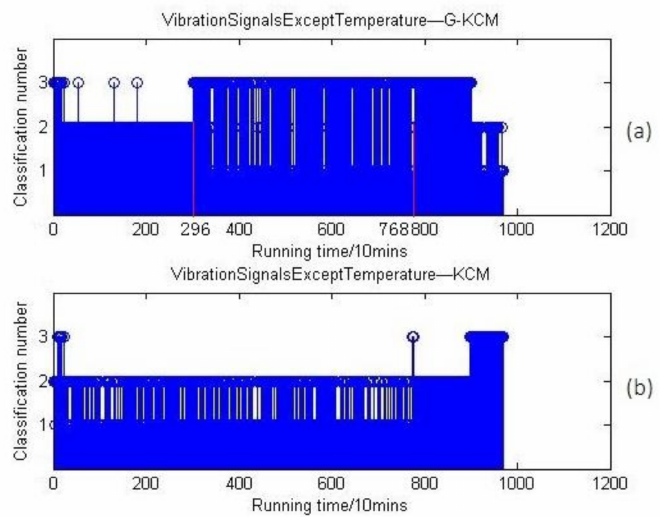
Figure 20. ( a ) Vibration signals except temperature clustering results based on G-KCM; ( b ) vibration signals except temperature clustering results based on